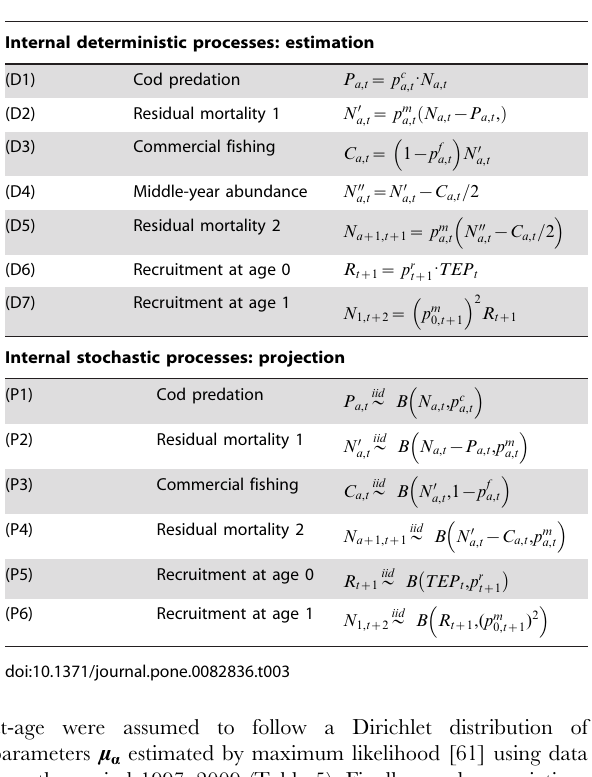
indicates the estimated a ,2009